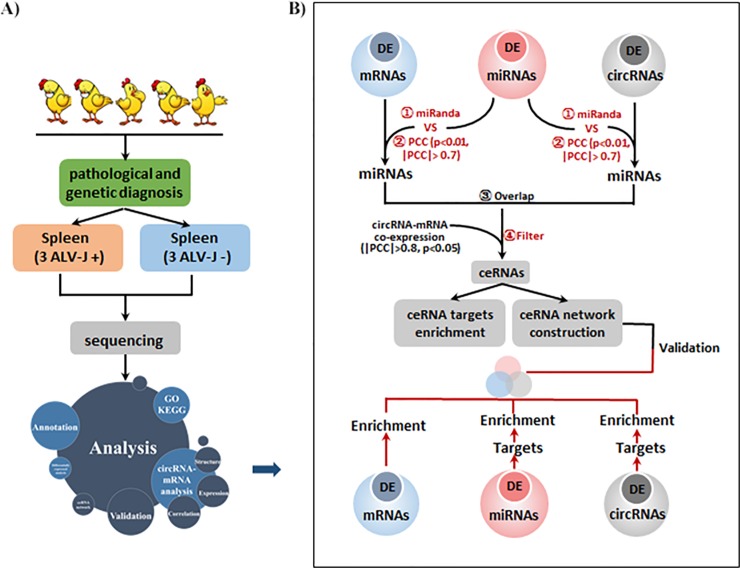
A schematic representation of the study design and computational analysis.